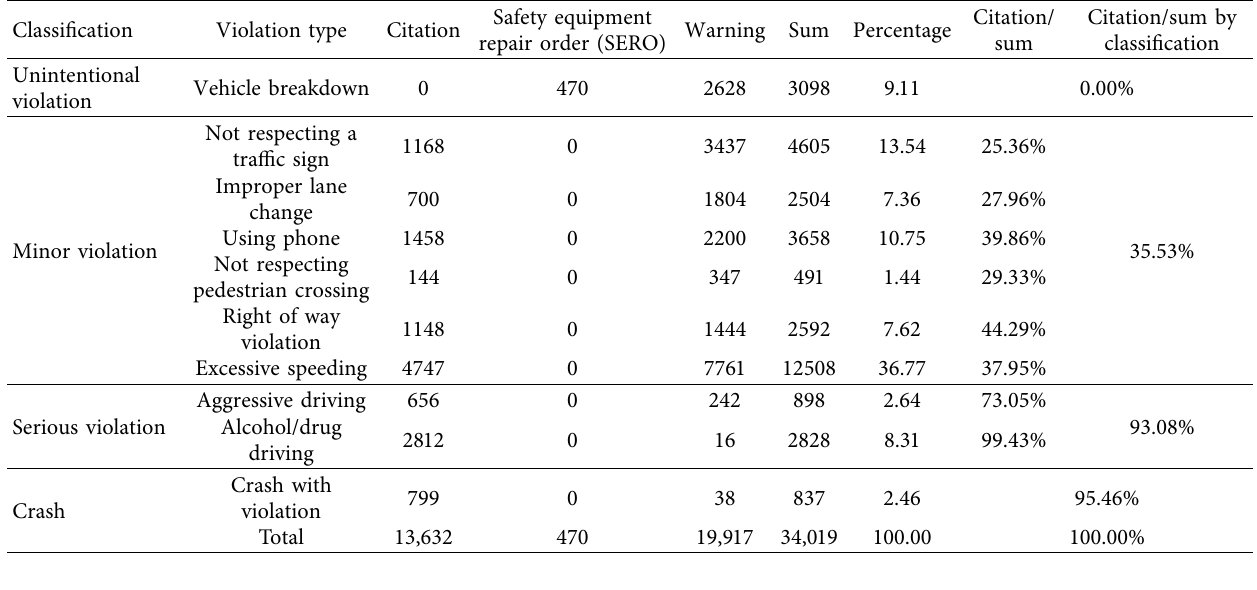
Table 1: Descriptive statistics of different violation types.